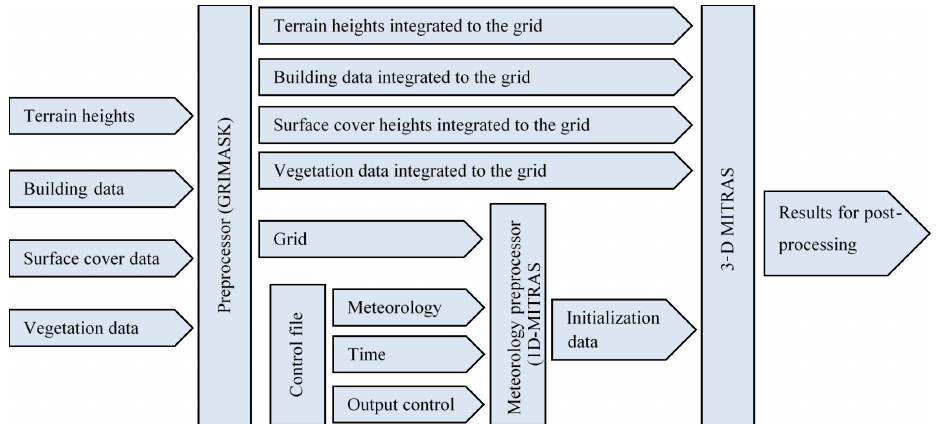
Figure 4. Principal elements of the MITRAS model